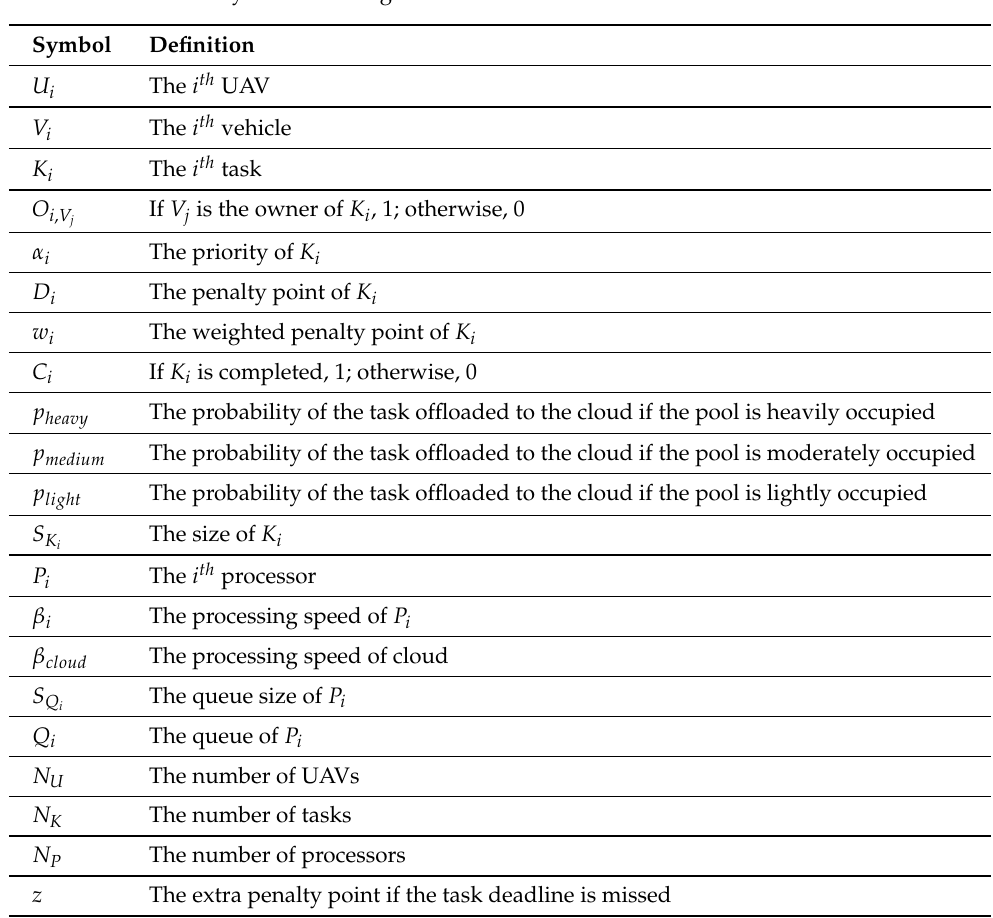
Table 1. Notations in system